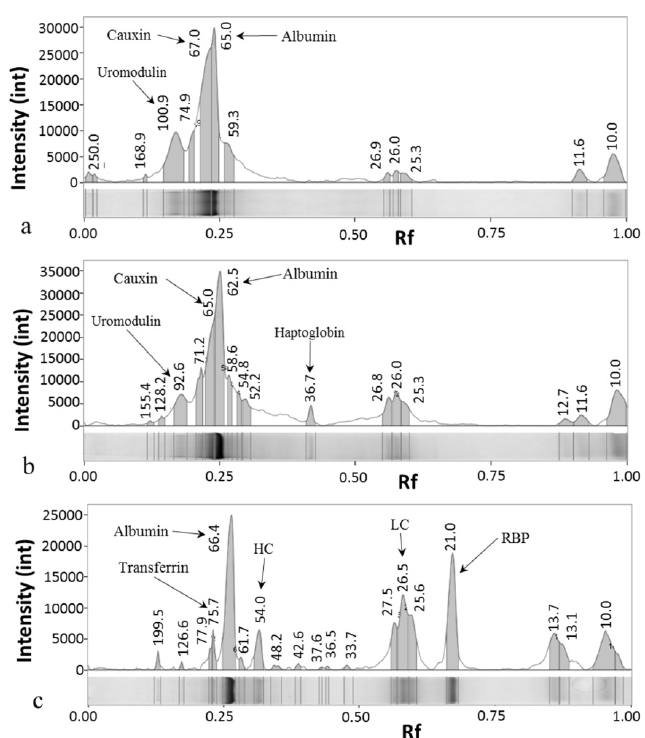
Figure 2. Representative pherograms of cat urine samples: ( a ) Healthy cat (same sample of lane 3 Figure 1); ( b ) FeMV cat (same sample of lane 5 Figure 1); ( c ) CKD cat (same sample of lane 9 Figure 1). The number above each peak correspond to the Molecular Mass of the band in kD. Arrows indicates the